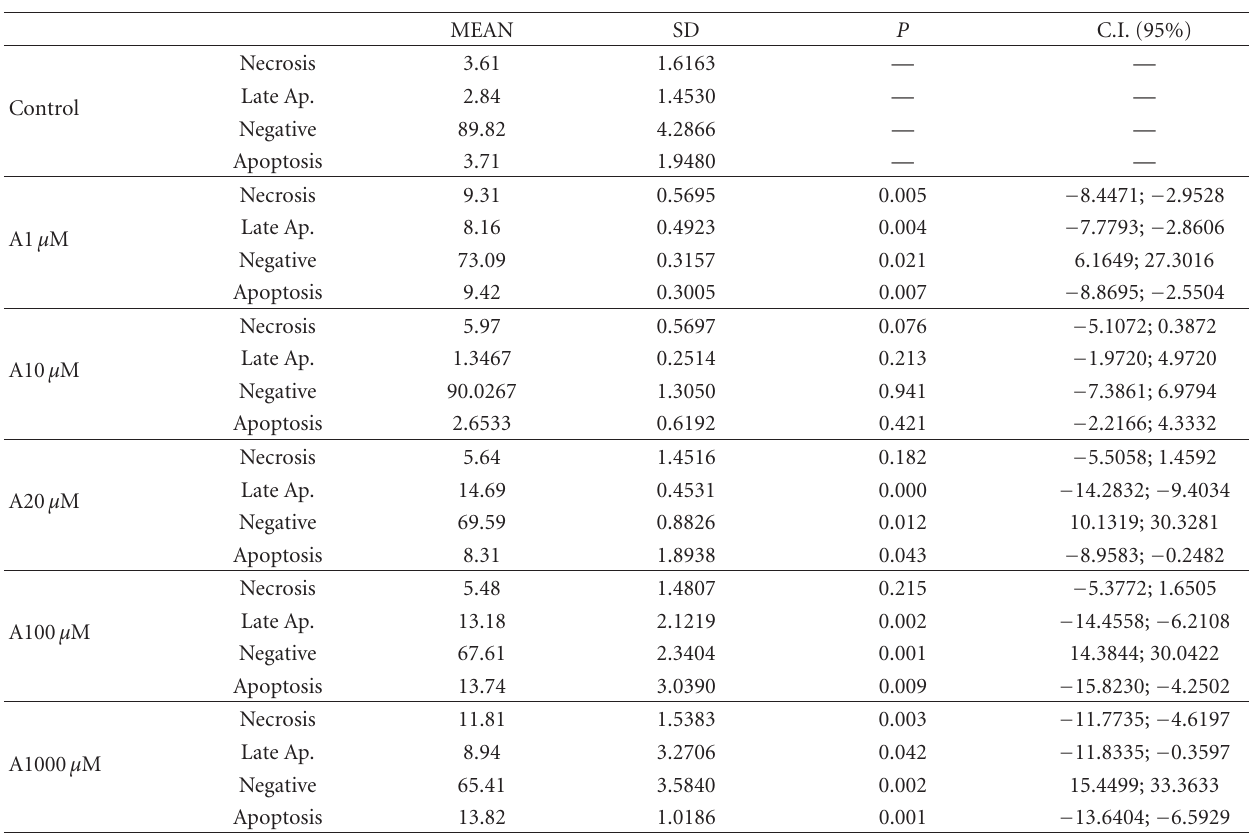
Table 2: Numerical data for the percentage annexin V binding and propidium iodide uptake of MG63 cells after culture for 12 h. Q1 (necrosis: Ann V − , PI + ), Q2 (late apoptosis: Ann V + , PI + ), Q3 (viable cells: Ann V − , PI − ), Q4 (early apoptosis: Ann V + PI − ). Data are means ± standard derivation of at least three independent